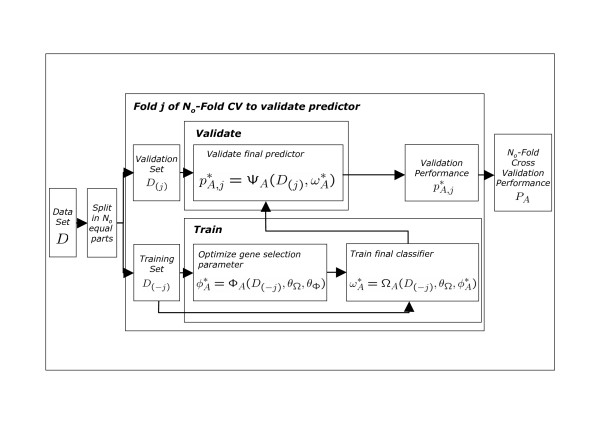
The training-validation protocol employed to evaluate various gene selection and classification approaches in simplified schematic format. The input is a labeled dataset, D, and the Output is an estimate of the validation performance of algorithm A, denoted by PA The most important steps in the protocol are the training step (Block labeled 'Train') and the validation step (Block labeled 'Validate'). The training step, in turn, consists of two steps, namely 1) the optimization of the gene selection parameter, ϕ, employing a Ni – fold cross validation loop and 2) training the final classifier glven the optimal setting of the selection parameter. The validation step estimates the performance of the optimal trained classifier ((ωA*)
 MathType@MTEF@5@5@+=feaafiart1ev1aaatCvAUfKttLearuWrP9MDH5MBPbIqV92AaeXatLxBI9gBaebbnrfifHhDYfgasaacH8akY=wiFfYdH8Gipec8Eeeu0xXdbba9frFj0=OqFfea0dXdd9vqai=hGuQ8kuc9pgc9s8qqaq=dirpe0xb9q8qiLsFr0=vr0=vr0dc8meaabaqaciaacaGaaeqabaqabeGadaaakeaadaqadaqaaGGaciab=L8a3naaDaaaleaacqWGbbqqaeaacqGGQaGkaaaakiaawIcacaGLPaaaaaa@3227@) on the completely independent validation set.